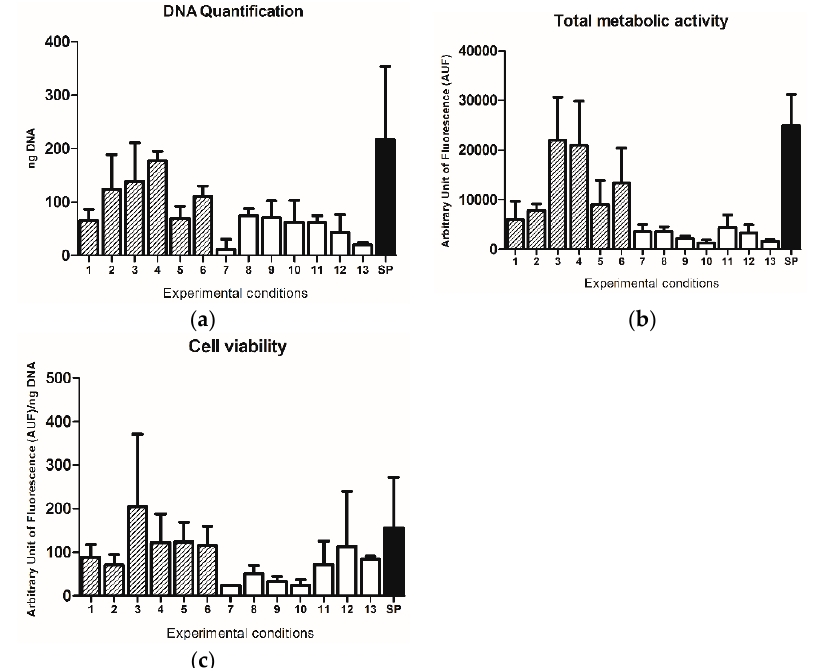
Figure 2. ( a ) DNA quantification, ( b ) total metabolic activity and ( c ) cell viability of samples for